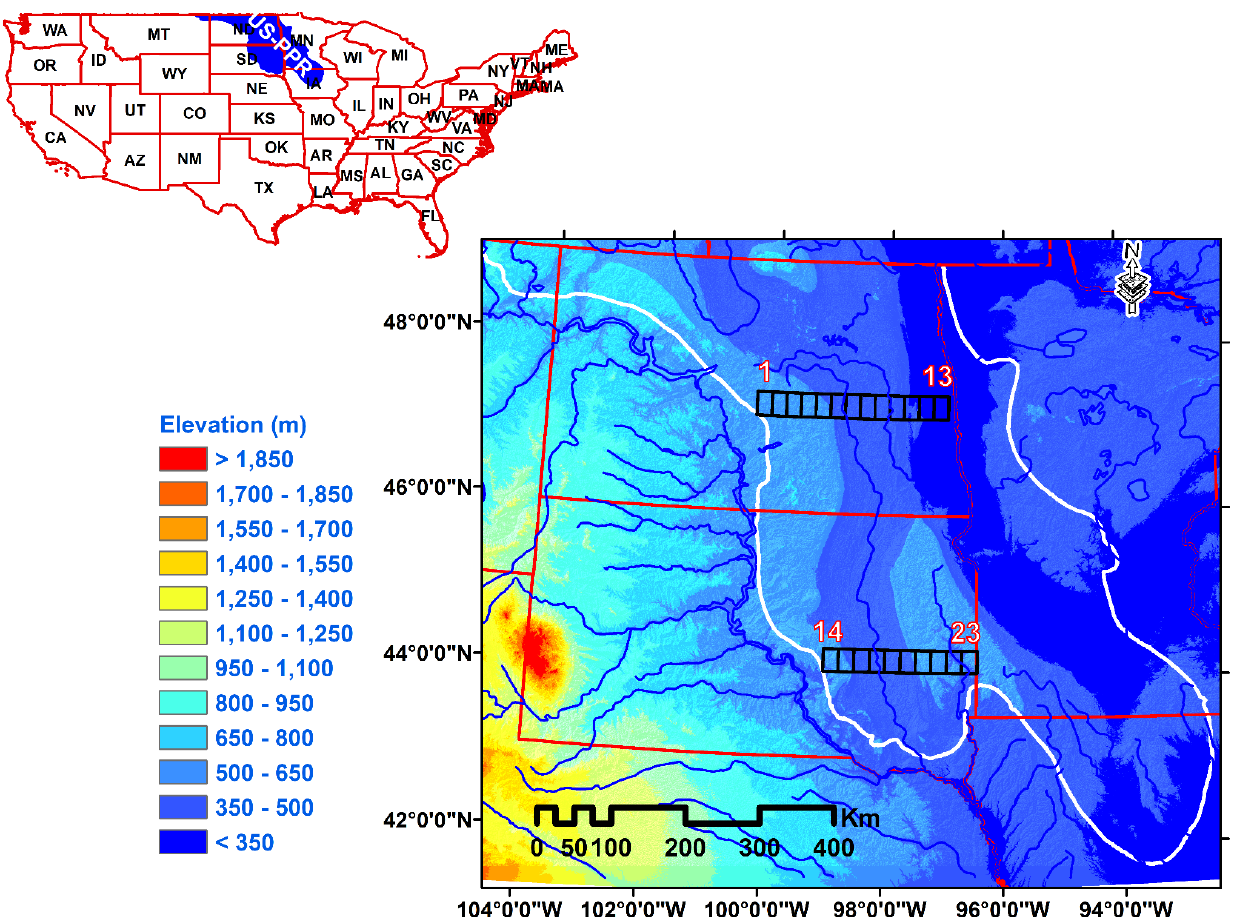
Figure 1. Location map of the US-PPR (Prairie Pothole Region) superimposed with the specific transects of AMSR (Advanced Microwave Scanning Radiometer) pixels in North Dakota (1–13) and South Dakota (14–23), 30m resolution digital elevation model (DEM), and rivers.